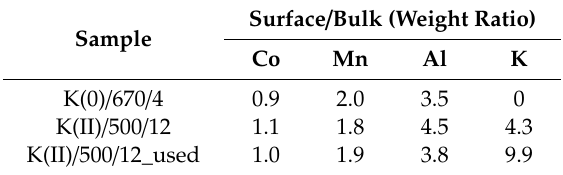
Table 6. Ratio of weight percentages of surface and bulk concentrations of the metals.